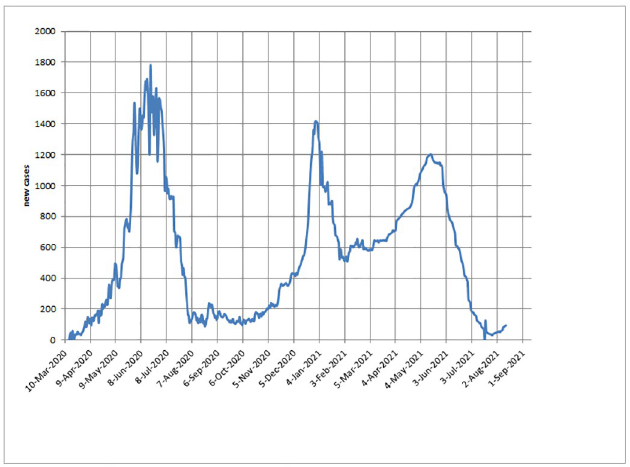
Fig 1. Daily new cases in Egypt reported from WHO data appeared the daily new cases which explain the start date and the end date for the three